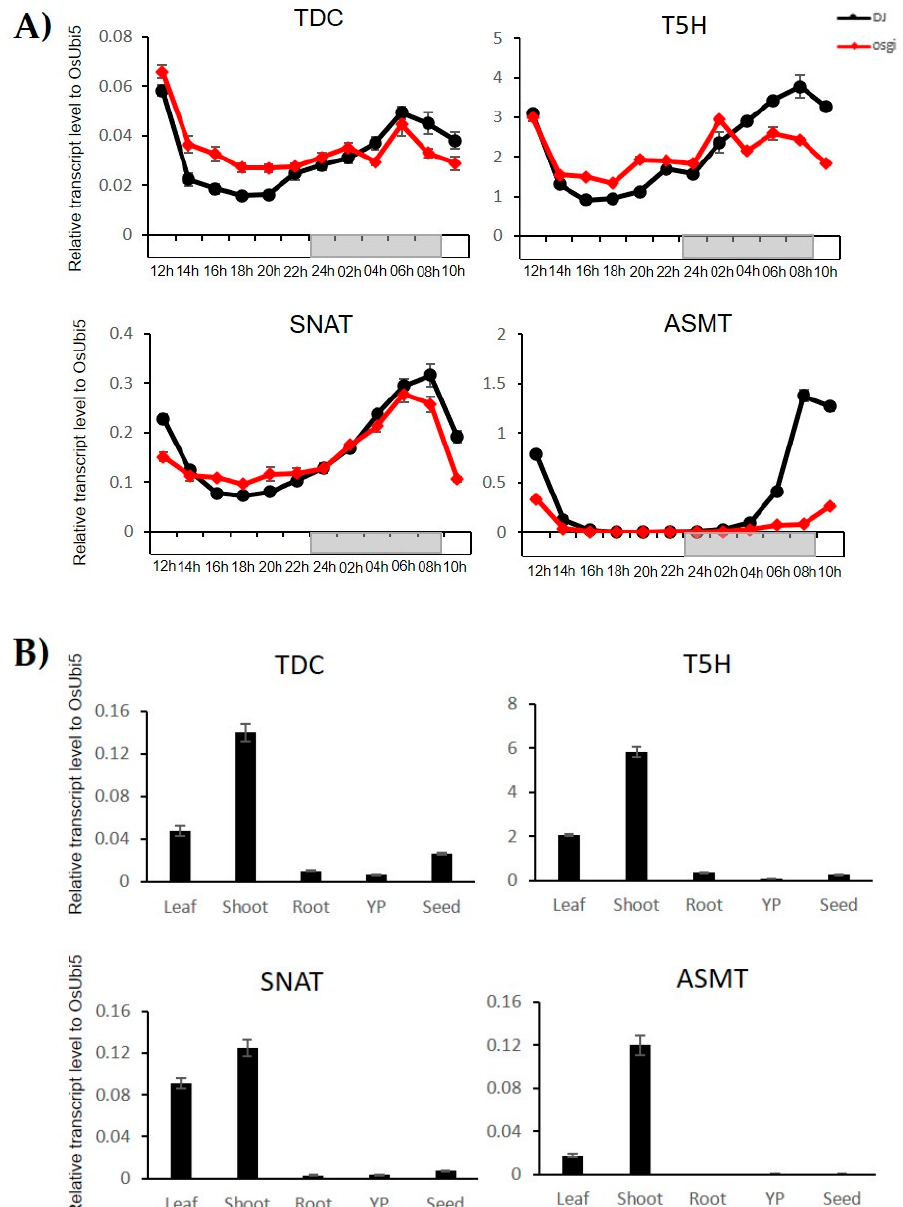
Figure 3. Expression profiles of four melatonin biosynthetic genes at 12 time points over a 24 h period in “Dongjin” rice (DJ) and the OsGI mutant ( A ), and in five tissues/organs ( B ). The continuous white and gray bars indicate day and night time, respectively. The anatomical samples used were five tissues/organs: leaf blade (LB), shoot, root, young panicle (YP), and seed. OsUbi5 was used as the internal control. Y-axis, relative expression level compared with OsUbi5.